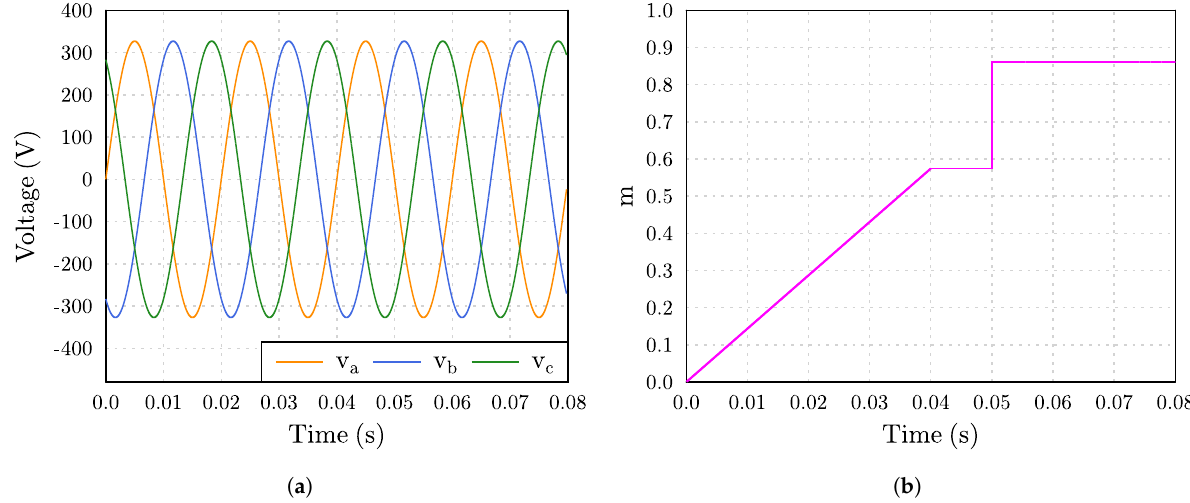
Figure 13. ( a ) Input voltages of the DMC controlled by SVM. ( b ) Modulation